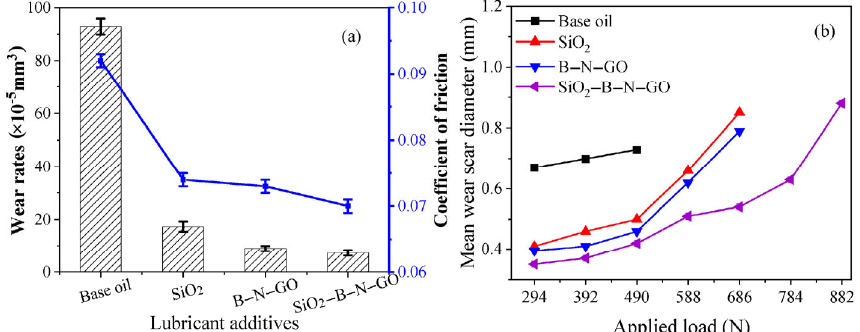
Fig. 7 (a) Variations of the wear rates and coefficients of friction for the base oil with different lubricant additives at the optimal concentration (0.15 wt%) with an applied load of 392 N, a sliding speed of 1,200 rpm, a temperature of 75 °C, and a test duration of 60 min. (b) The mean wear scar diameters are shown to increase with an increasing applied load for the base oil with different lubricant additives at the optimal concentration (0.15 wt%) for 60